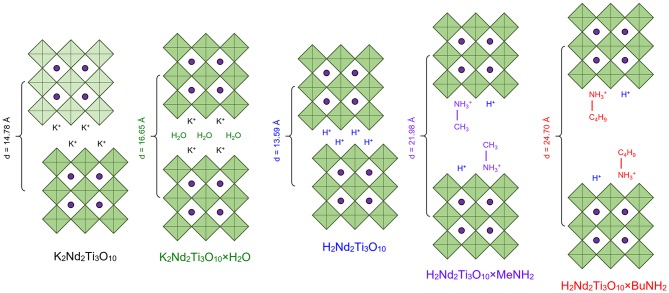
Schematic representation of the interlayer distance change at different synthetic steps.